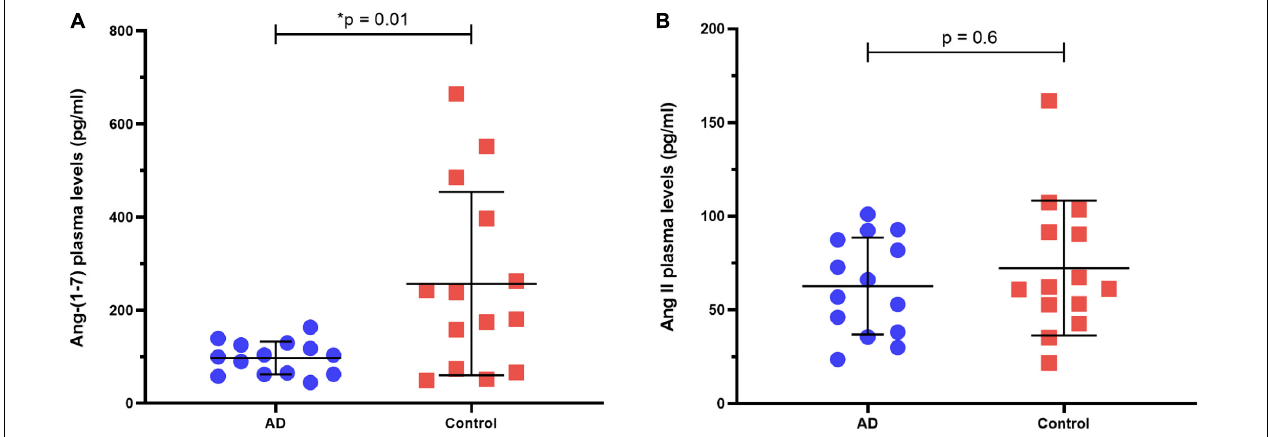
FIGURE 1 | Ang-(1–7) and Ang II plasma levels in AD patients vs. controls. (A) AD patients had smaller levels of Ang-(1–7) compared to controls. (B) AD patients and controls had similar levels of Ang II. Horizontal bars represent the upper quartile, median, and lower quartile. P -values from Mann-Whitney U